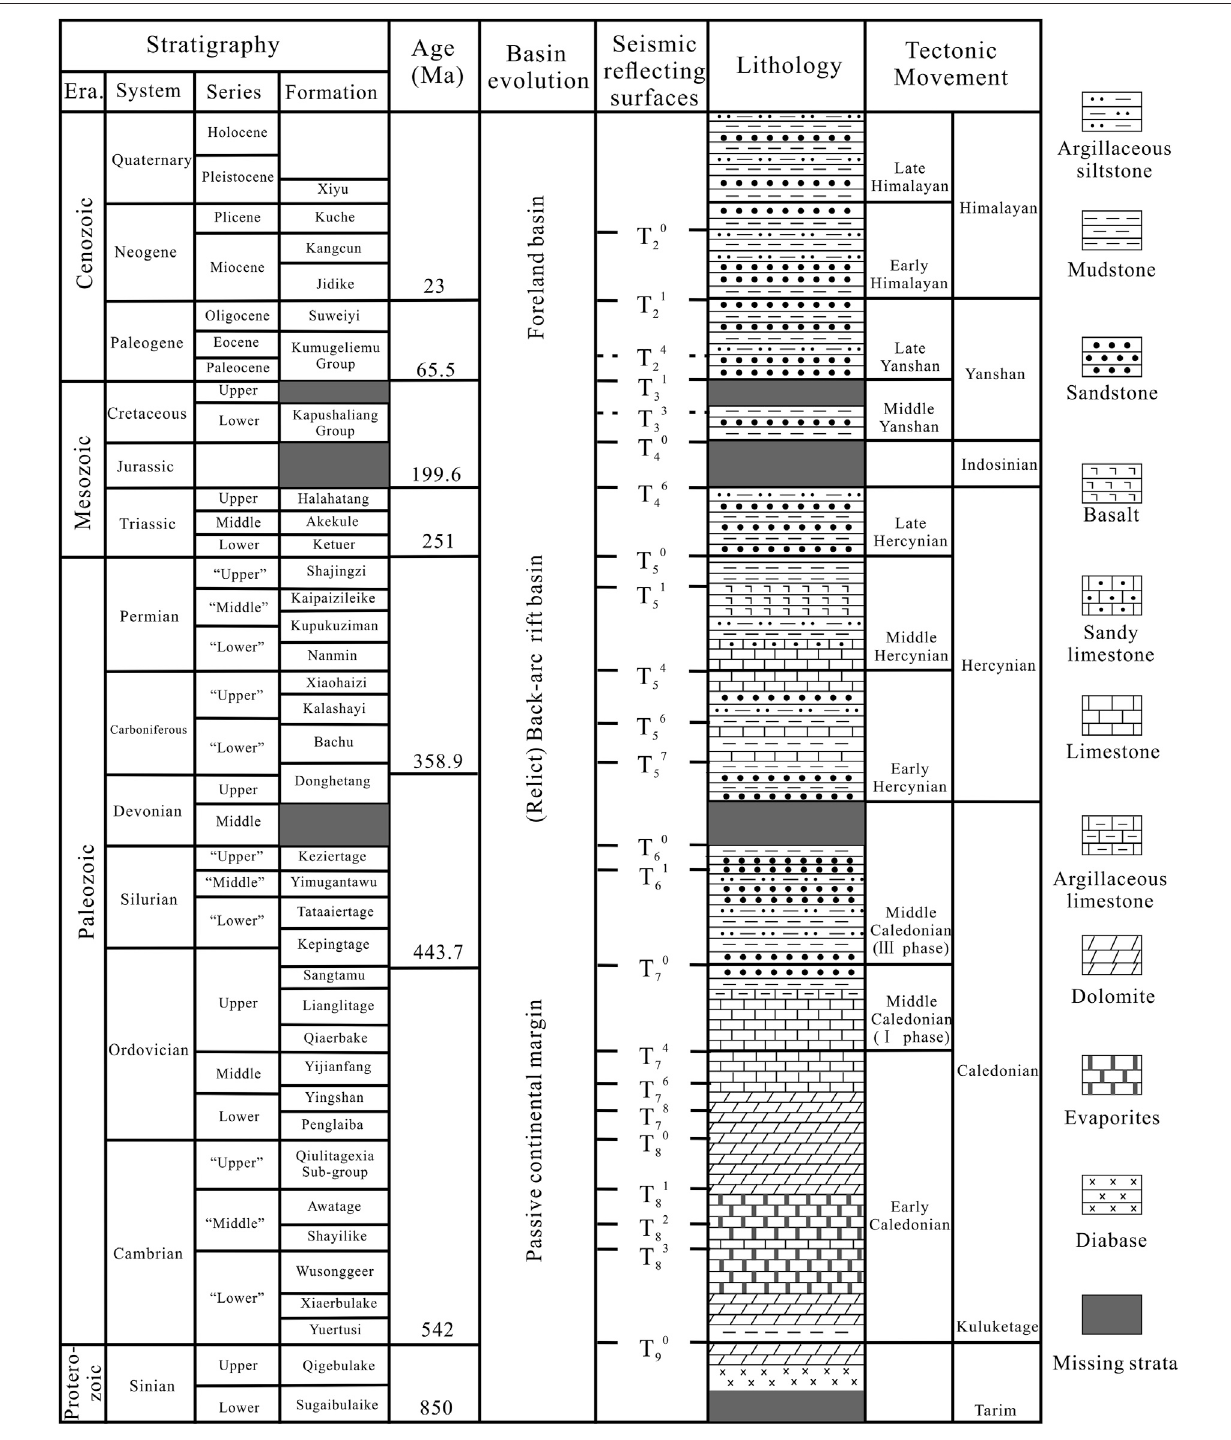
boundary between the Upper Ordovician and Middle Ordovician) were used to analyze the structural characteristics of faults and fault combinations.